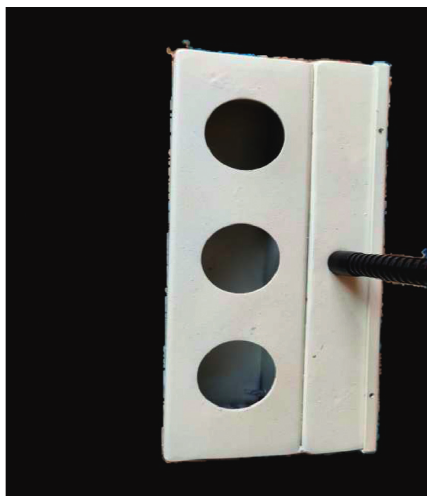
Figure 16: Plant holder